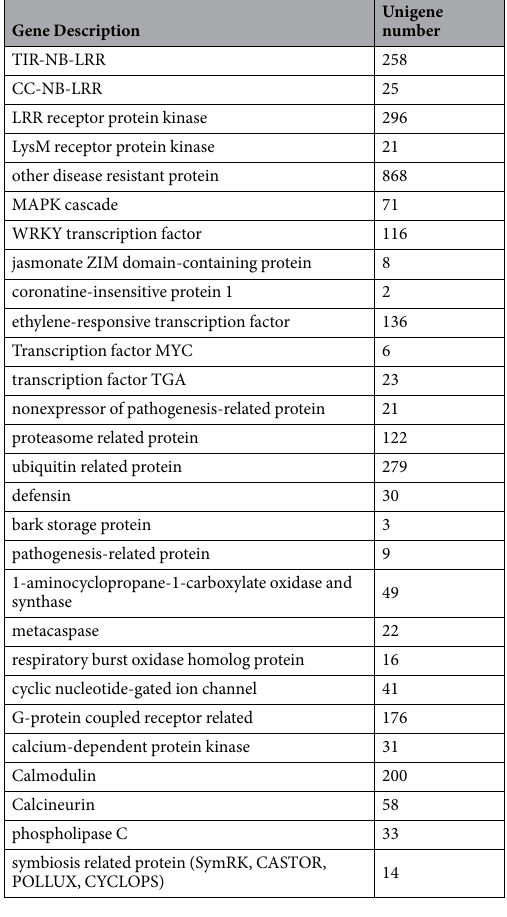
Table 3. Genes involve in plant-fungus